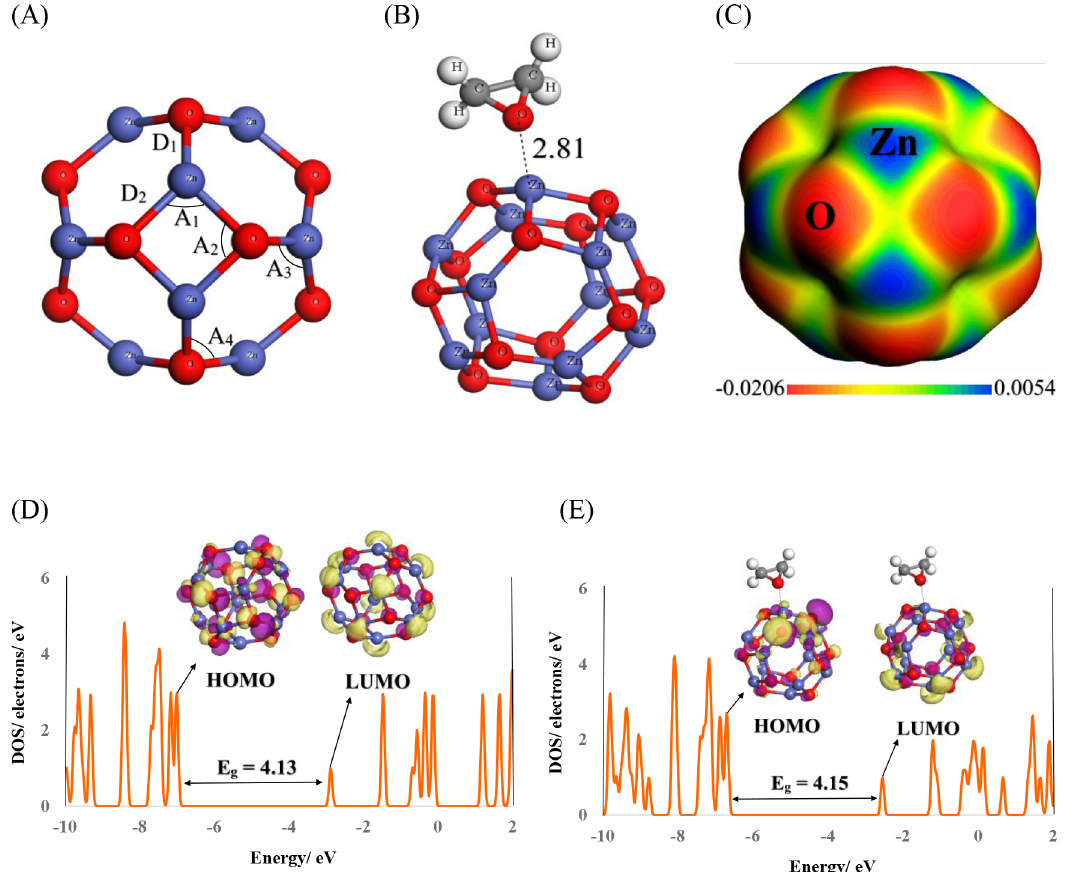
O , D and A means distance and angle, respectively; (b) Optimized structure of EO/Zn 12 12 O ; (d) DOS, HOMO and LUMO profiles of EO/Zn 12 12 O . Color ranges, in a.u.: blue, more positive than 0.0054; green, between 0.0054 and 0; yellow, between 0 and 12 12